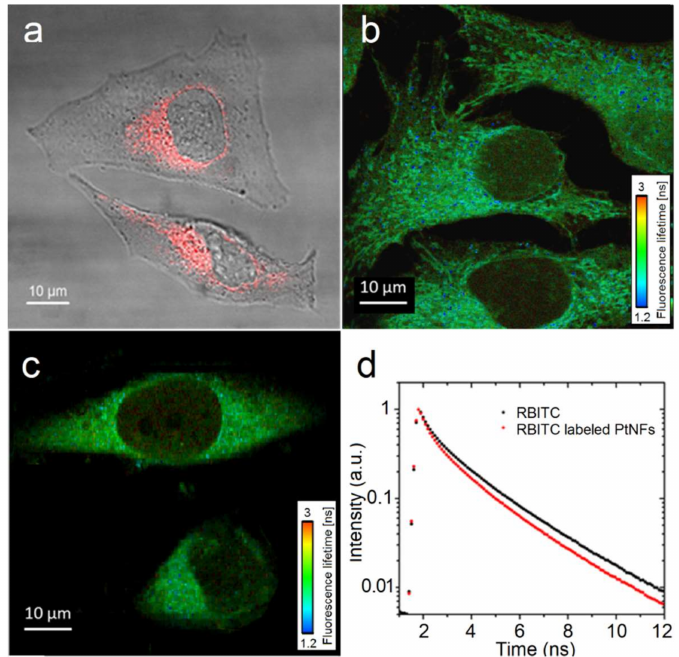
Figure 7. ( a ) Merged image of the transmission and fluorescence images obtained by confocal microscopy of HeLa cell loaded with RBITC labeled Pt NFs at a concentration of Pt of 5 × 10 − 4 mol L − 1 , incubated for 6 h; ( b , c ) The Fluorescence Lifetime Imaging Microscopy (FLIM) imaging of cervical cancer cells (HeLa) incubated with RBITC labeled Pt NFs and free RBITC respectively, fluorescence lifetime is showed in the nanosecond range; ( d ) Fluorescence decay curves (mean lifetime curve) of the free RBITC (black) and of the RBITC labeled Pt NFs (red) after an excitation at 550